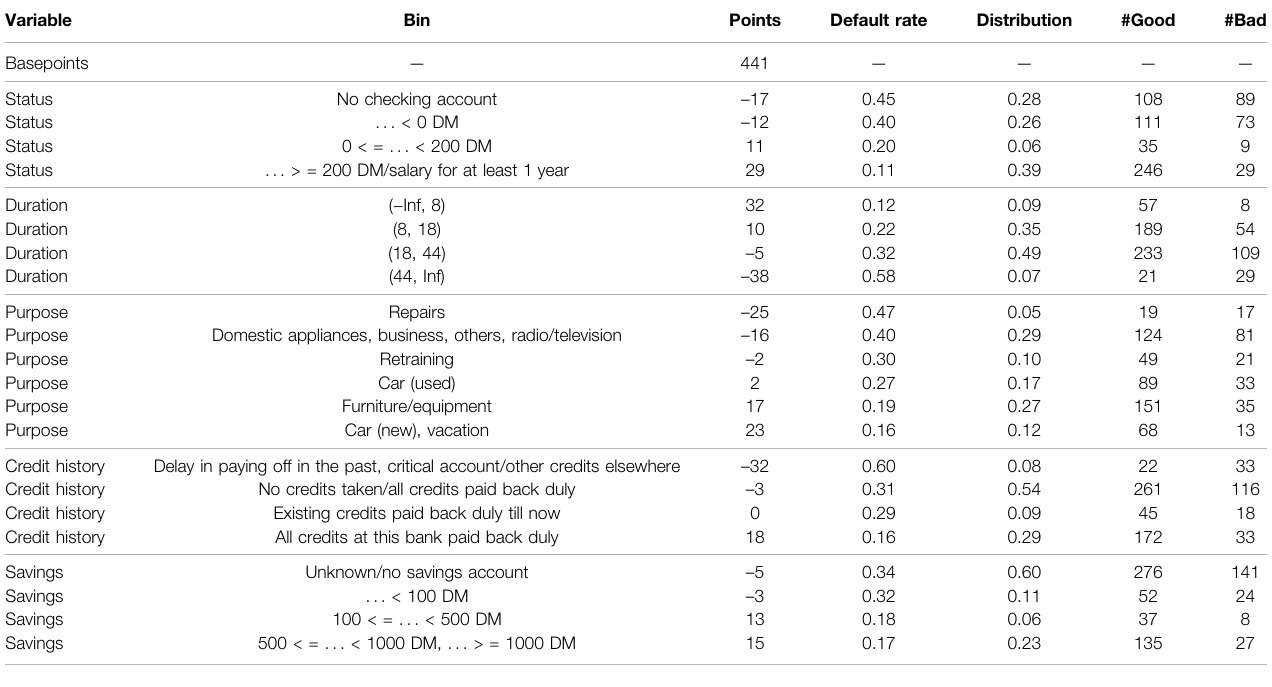
TABLE 6| Resulting scorecardmodel. Inpracticeitisusualtoassignscorecard pointstotheposterior probabilitiesasgivenbythescore.Here,acalibrationwith500points at odds of 1/19 and 20 points to double the odds is used.